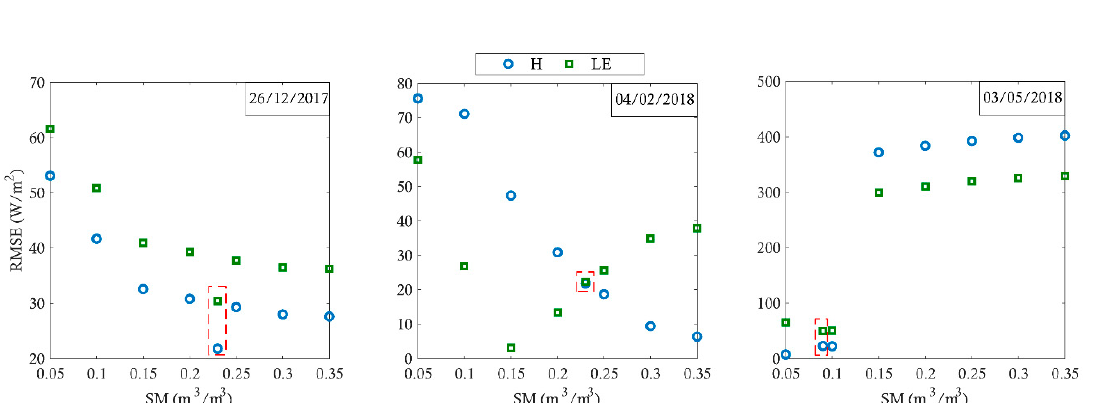
Figure 7. Scatterplot of simulated versus observed Rn, G, LE, and H using the three approaches at the Sidi Rahal site.